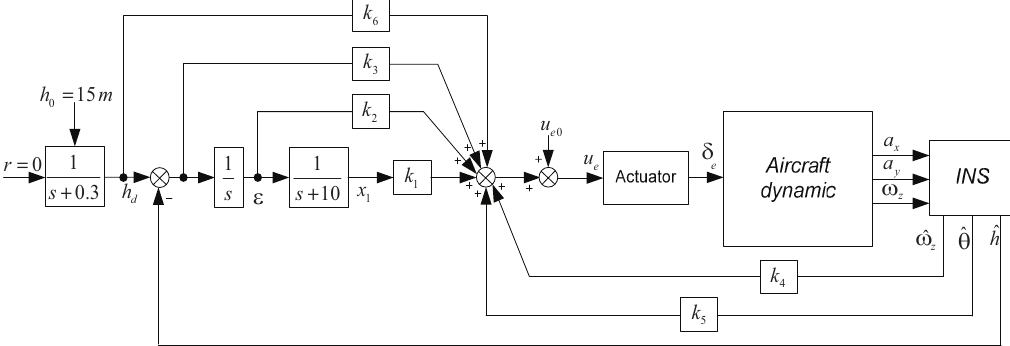
Figure 11. Automatic